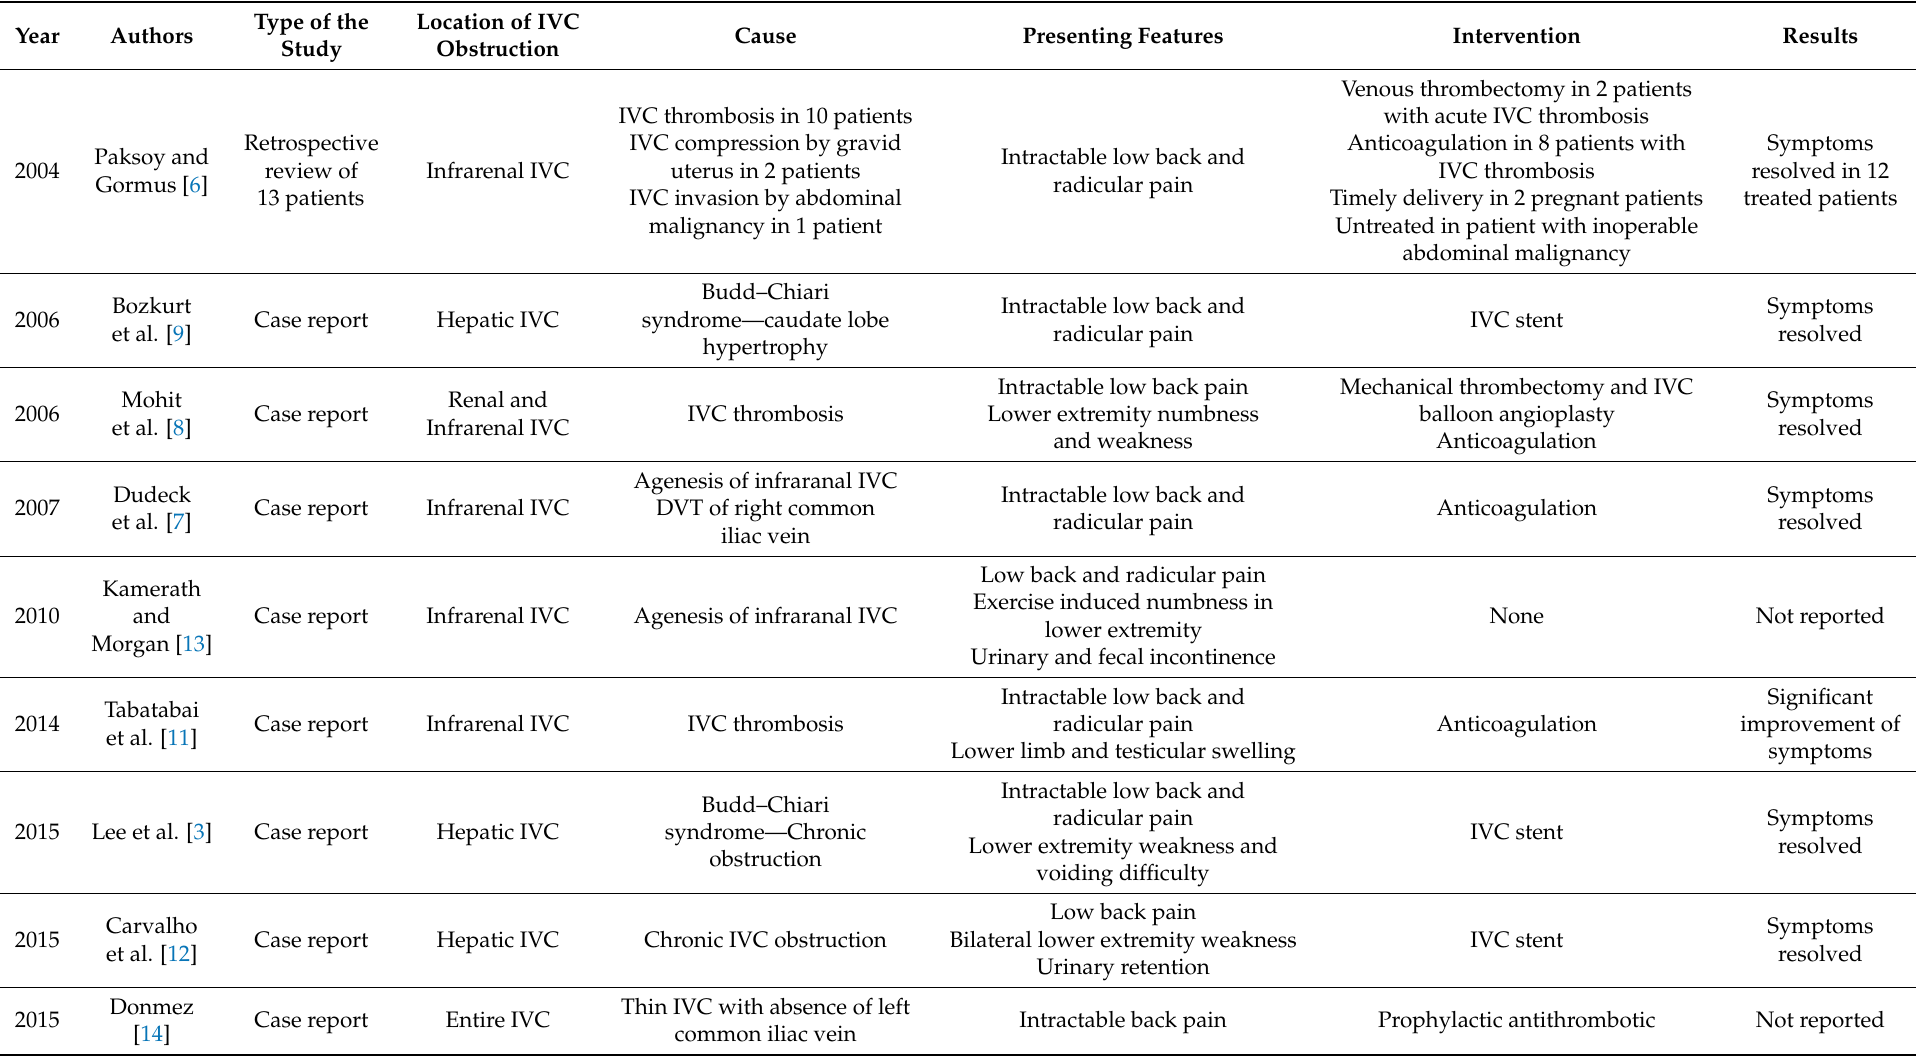
Table 4. Literature review for back pain in IVC